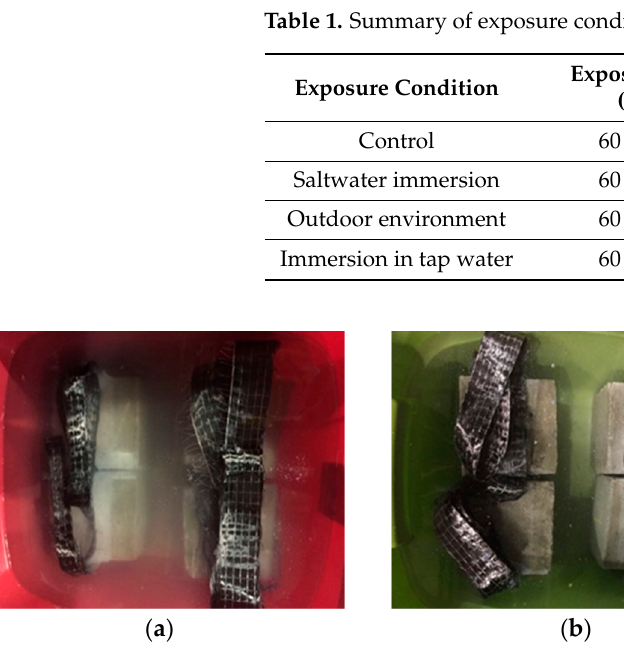
Figure 2. The full immersion procedures for the specimens of the pull-off shearing tests. ( a ) The saltwater exposure. ( b ) The tap water exposure. ( c ) The outdoor exposure. Table 1. Summary of exposure conditions used to weather the specimens.